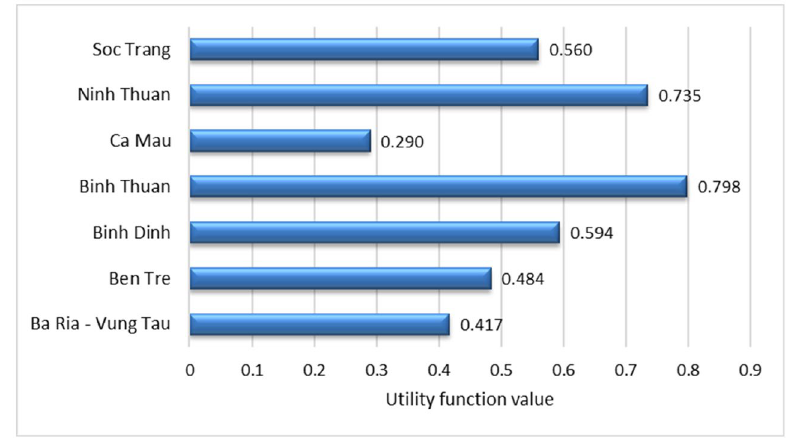
Figure 6. Location ranking of the WASPAS